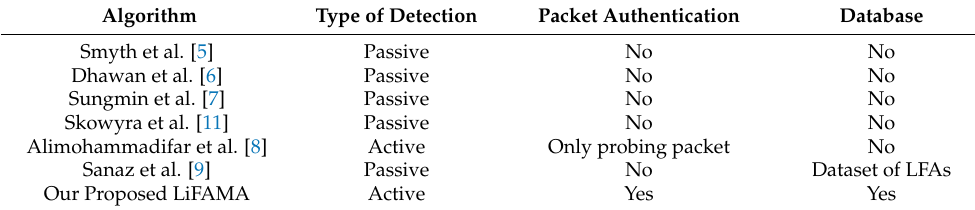
Table 1. Some existing LFA detection and mitigation approaches.